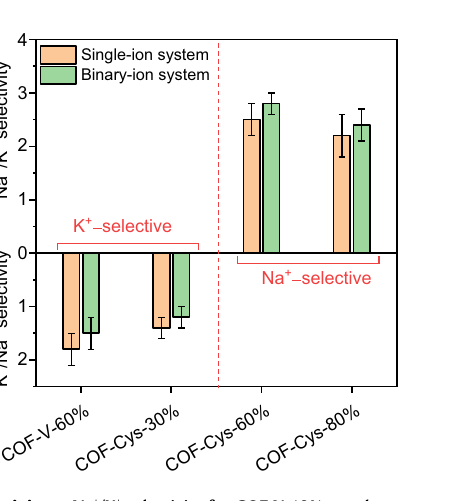
selectivityforCOF-Cys-60%membrane.Errorbarsin a and b representthestandard deviation for three independent